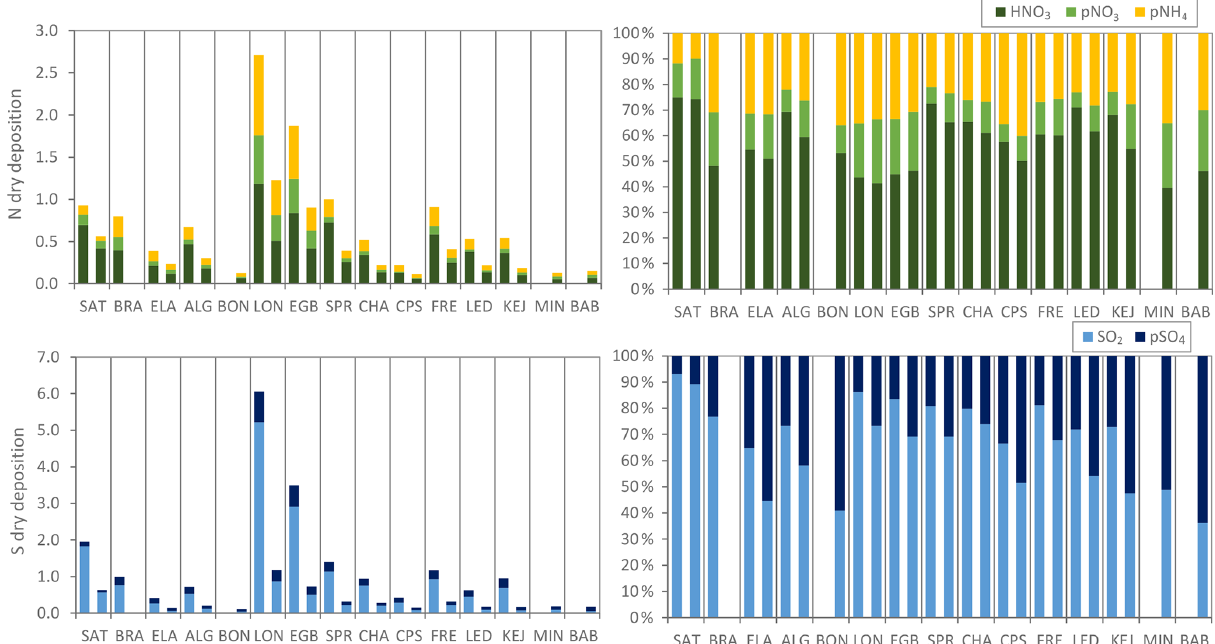
Figure 2. Dry N and S deposition fluxes (kgN or Sha − 1 yr − 1 ) and the percentage of N or S species in dry deposition for the 5 year period in 2000–2004 and in 2014–2018 at CAPMoN sites. For each site, the first bar represents the 2000–2004 values and the second bar represents the 2014–2018 values. Gaseous species: HNO 3 and SO 2 ; particulate (p) species: pNO 3 , pNH 4 , and pSO 4 . Sites are listed in order longitudinally from west (left) to east